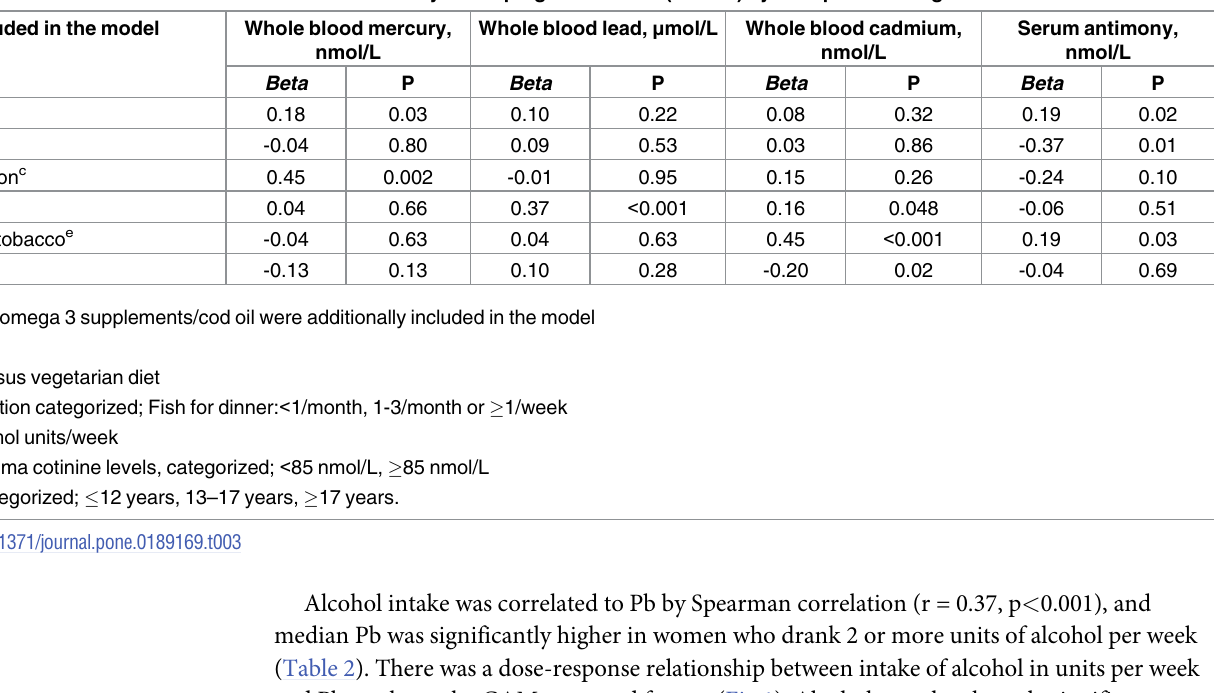
(Table 2). There was a dose-response relationship between intake of alcohol in units per week and Pb, as shown by GAM corrected for age (Fig 1). Alcohol was also the only significant pre- dictor for Pb in the multiple linear regression model (Table 3).